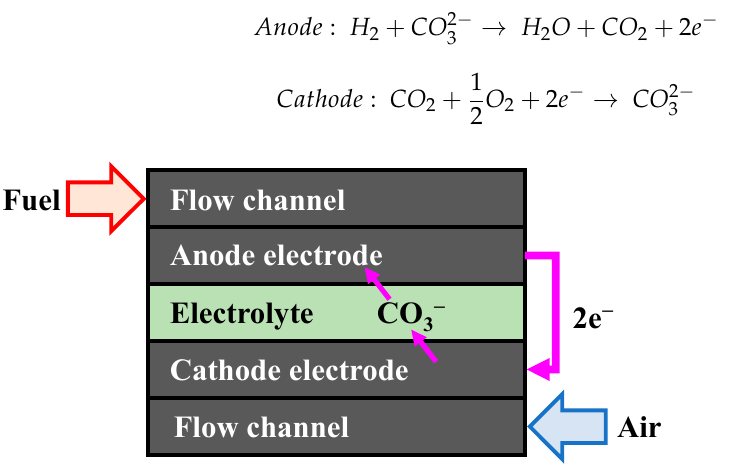
Figure 1. Schematic of the molten carbonate fuel cells (MCFCs).